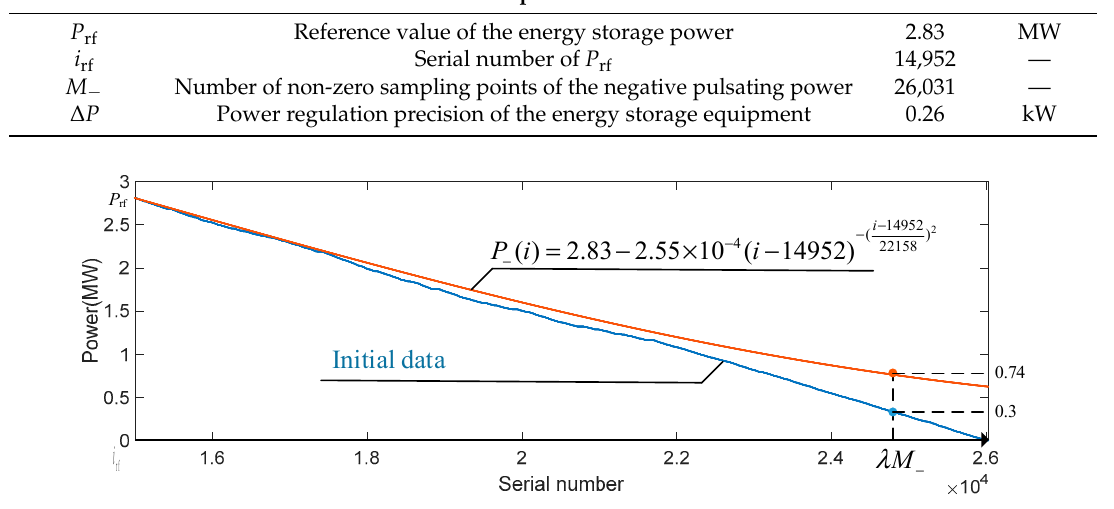
Figure 5. The approximate curve of the non-zero negative pulsating power.